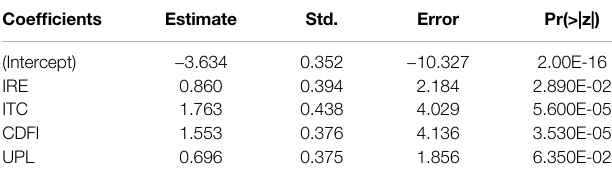
TABLE 6 | Results of the logistic regression analysis to determine the association between ultrasound characteristics and mTC malignancy. Coef fi cients Estimate Std. Error